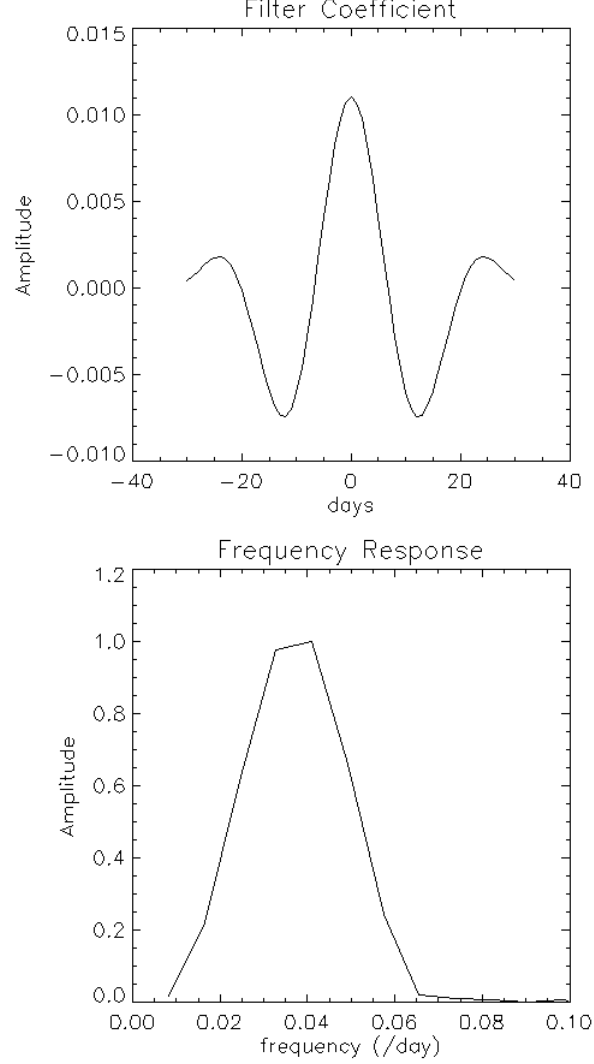
Fig. 12. Filter coefficients and frequency response for the 25–29 day band-pass filter used to isolate the quasi-27-day oscillation prior to its use for producing the scatter plots in Fig.